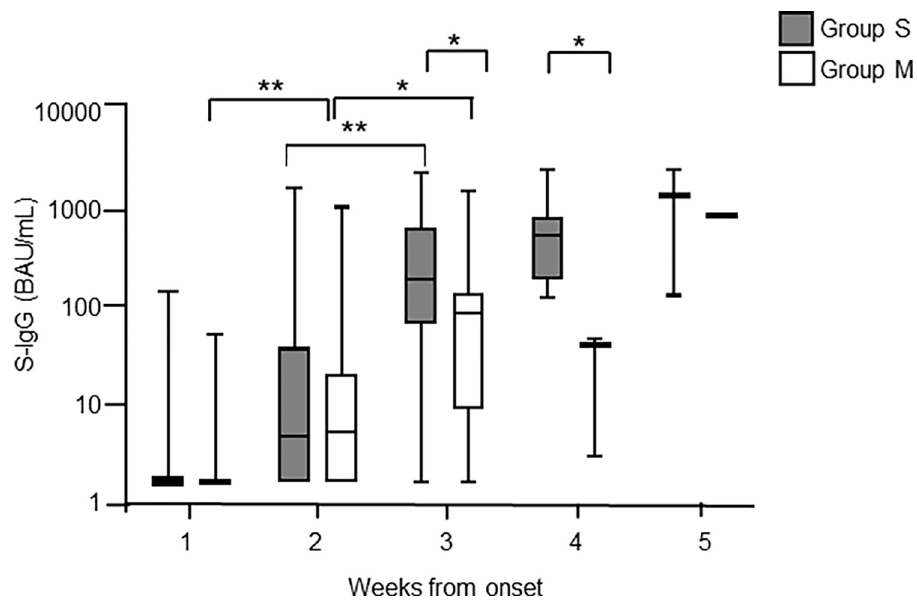
Fig 2. The time course of VITROS S-IgG titers in COVID-19 patients after symptom onset.